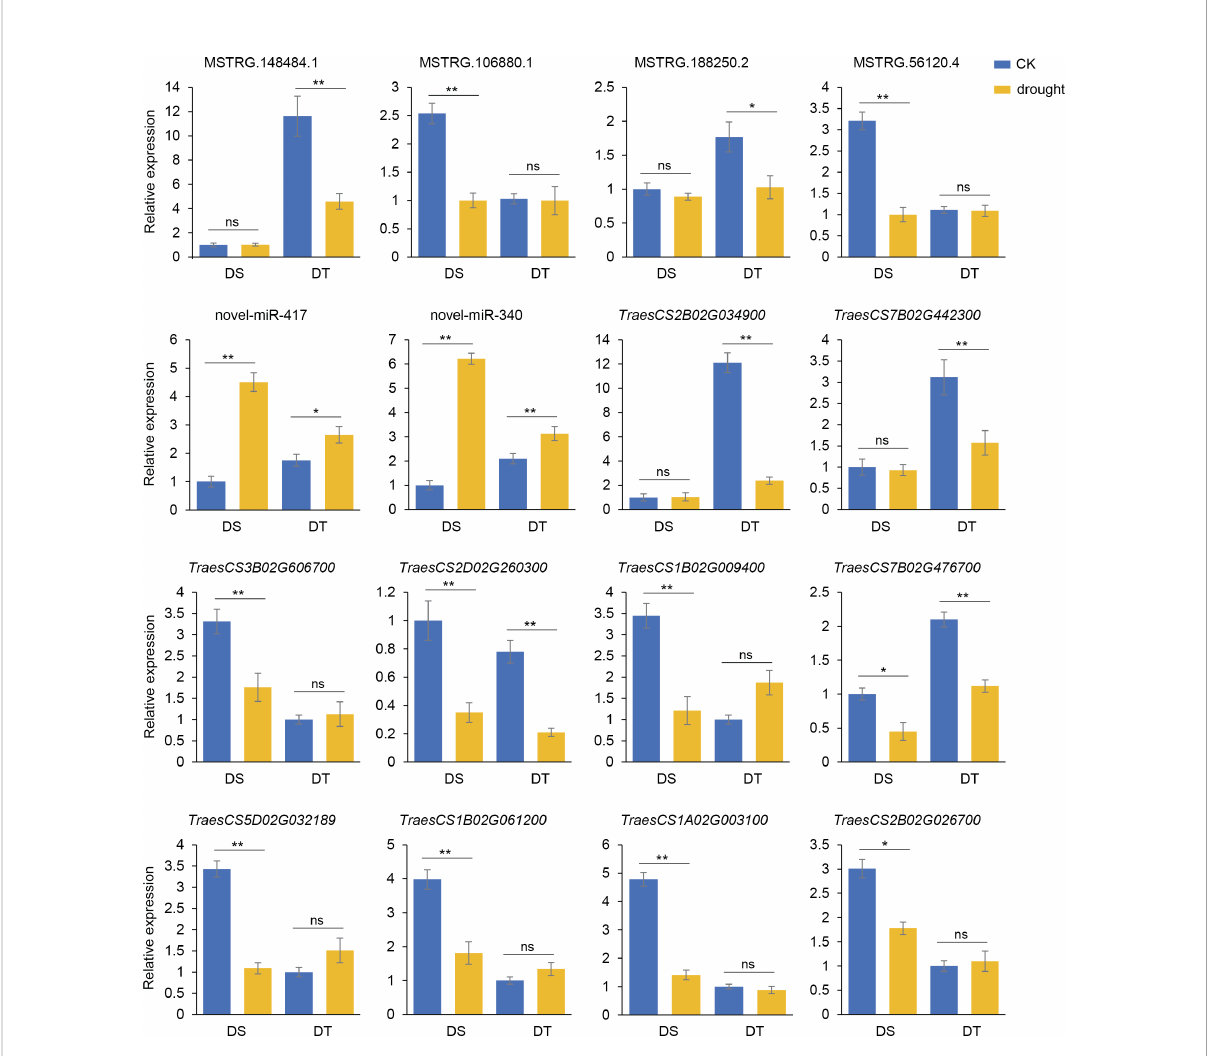
FIGURE 7 Validation of the expression patterns of lncRNA-miRNA-mRNA regulatory modules by qRT-PCR. The column represents the relative expression levels of qRT-PCR, and the broken line represents the log 2 (fold change) of RNA-seq or small RNA-seq. Values are means ± SD. * P < 0.05. ** P < 0.01. ns, no signi fi